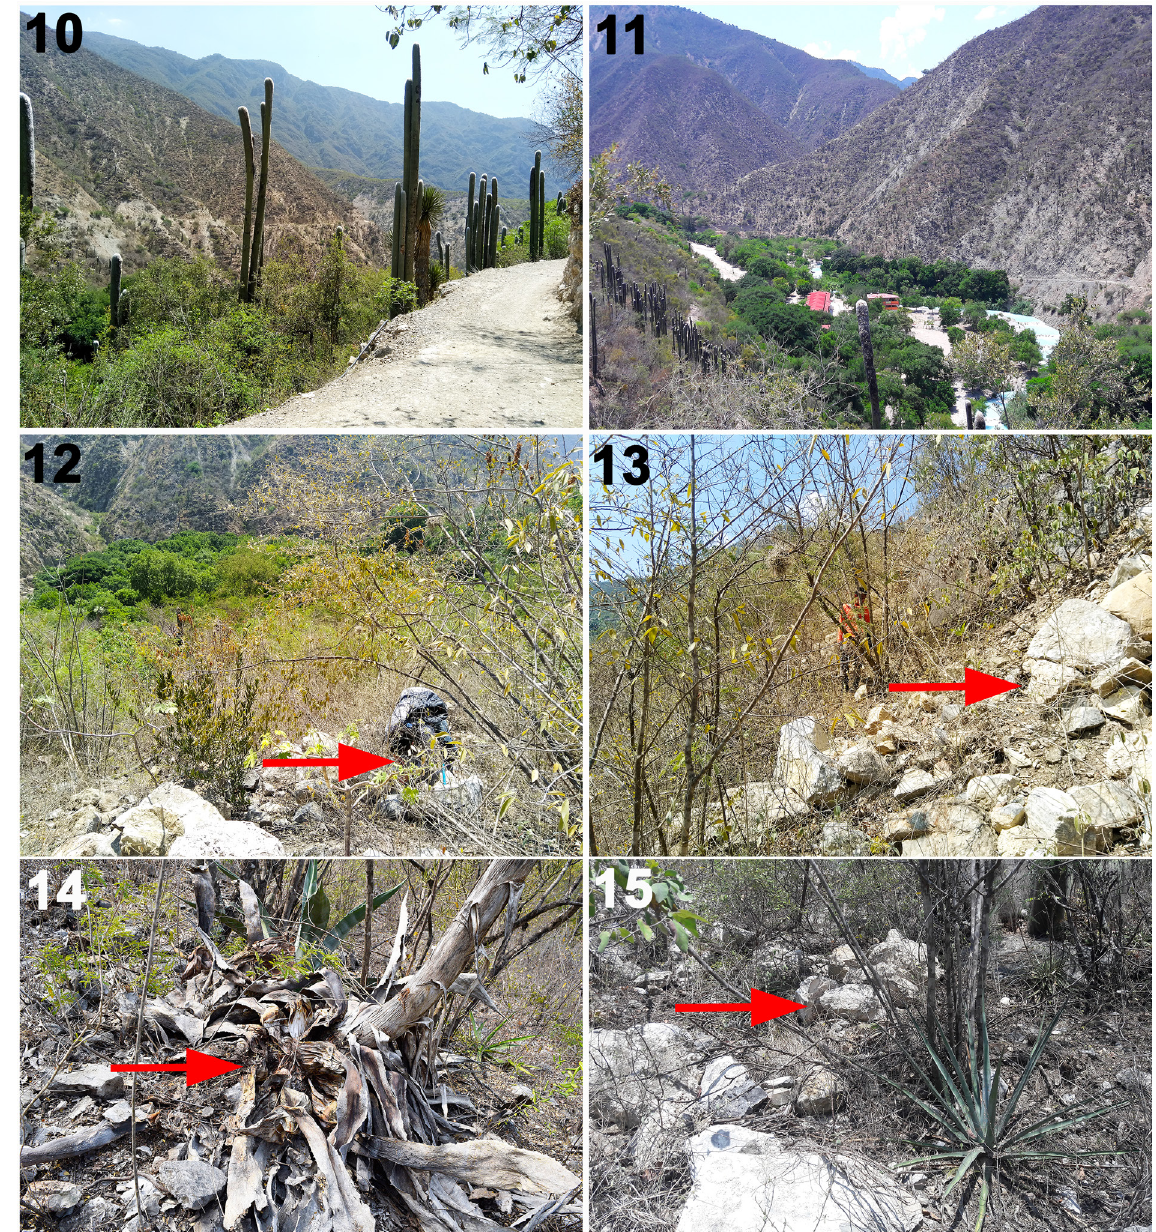
Figs 10–15. Habitat and microhabitat of Loxosceles tolantongo sp. nov. 10–11 . Xerophytic forest from the type locality: Tourist Center Grutas de Tolantongo, Municipality of Cardonal, Hidalgo, Mexico. 12–15 . Microhabitat situated 500 m west of entrance No. 5 to the Tourist Center Grutas de Tolantongo, Municipality of Cardonal, Hidalgo, Mexico (arrows indicate the microhabitat where the specimens can be found: under big rocks and inside of rotten and dry agave plants). Photos 10, 12–14 by Claudia Isabel Navarro-Rodríguez (2018); photos 11, 15 by Alejandro Valdez-Mondragón